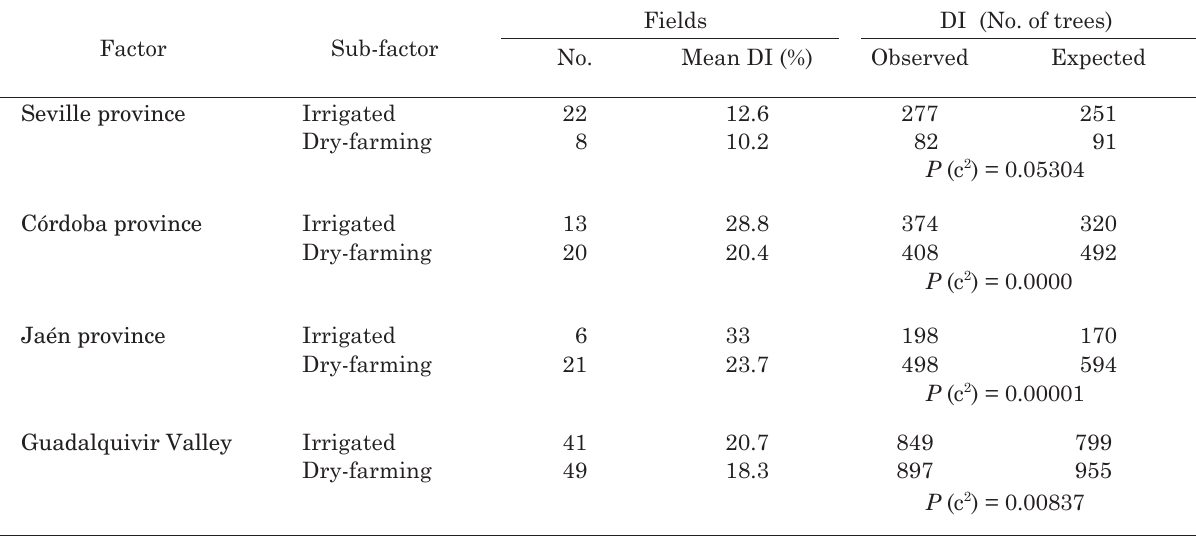
Table 2. Irrigation regime and incidence (DI) of Verticillium wilt of olive in the Guadalquivir